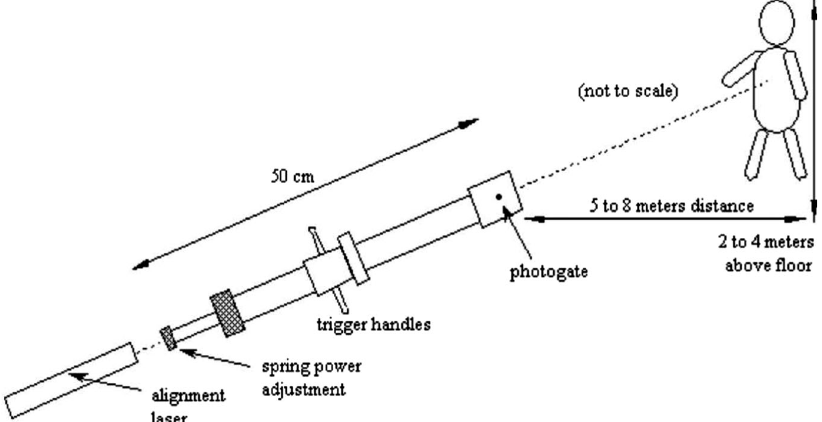
FIG. 2. Shoot the monkey setup schematic.